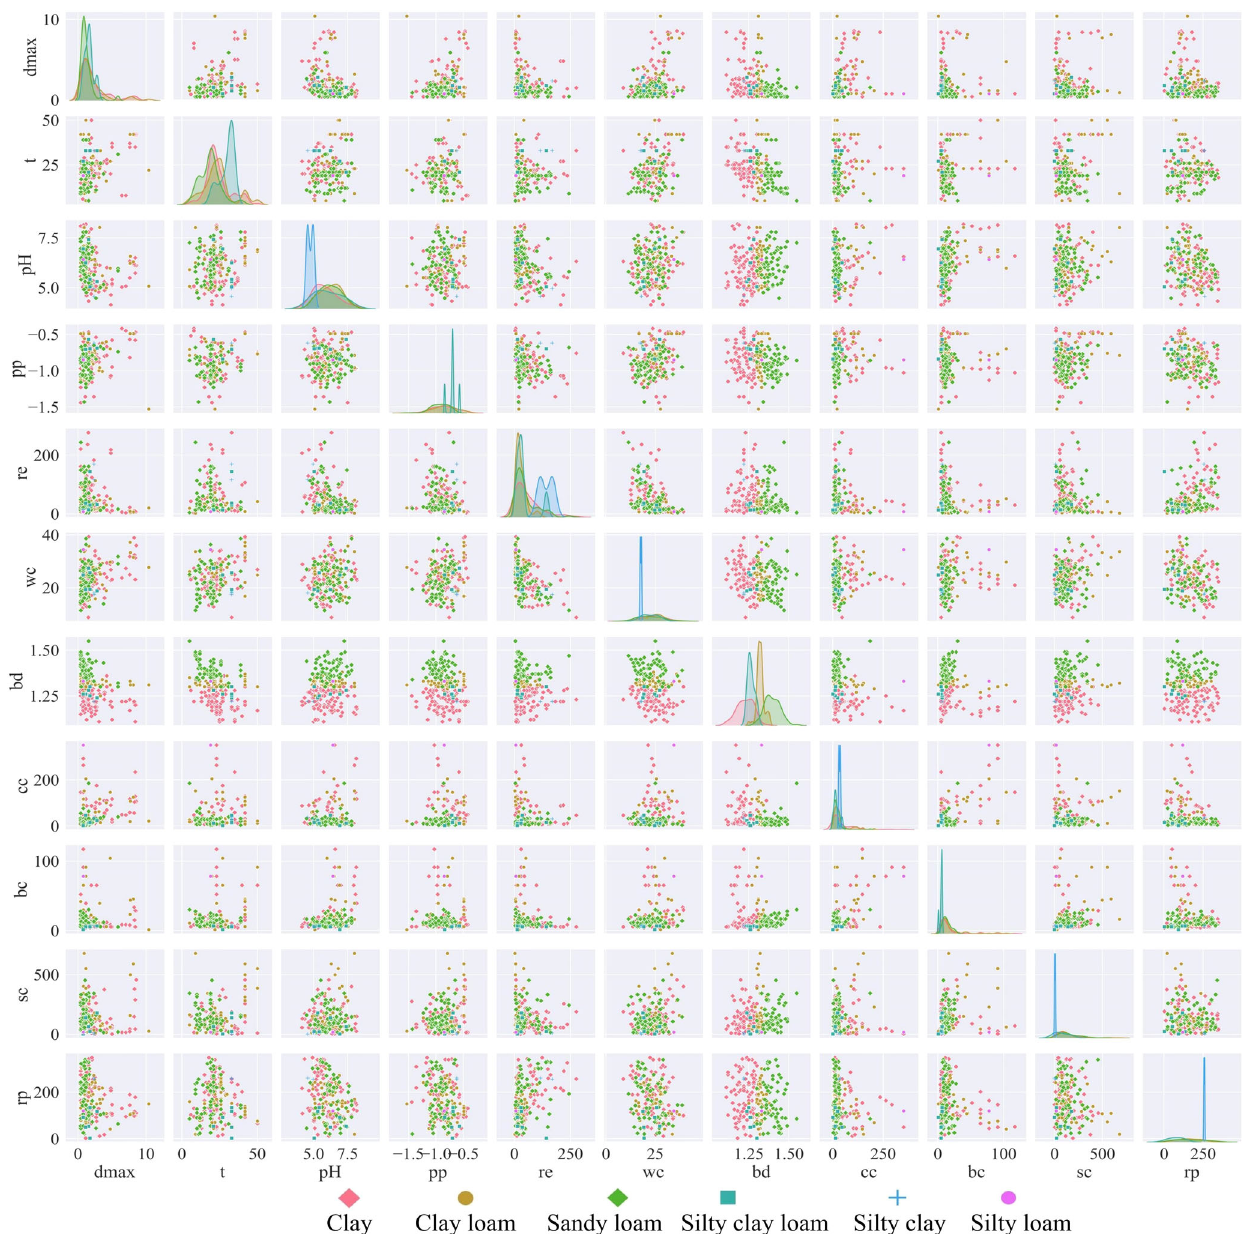
Fig. 12 Data distribution under different soil types. Samples were classi fi ed by soil type, and the overall distribution of these samples on the two feature dimensions was observed. Plots on the diagonal depicting the distribution of individual features for different soil type